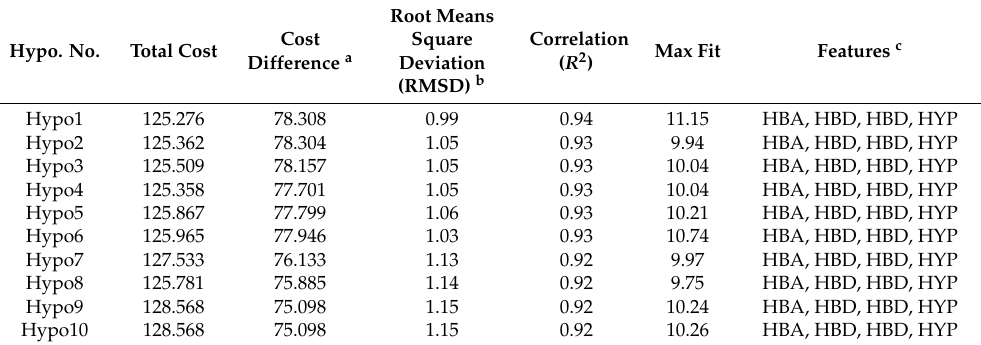
Table 1. Statistical data of ten pharmacophore hypotheses generated by HypoGen.